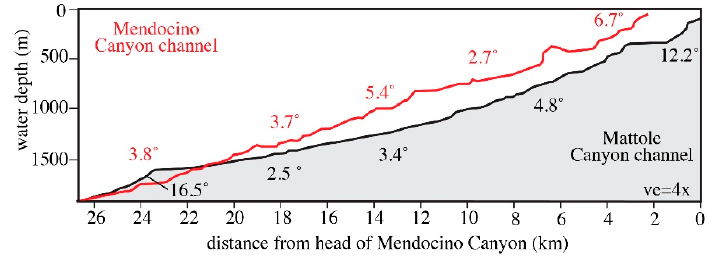
Figure 7. Thalweg profiles of Mendocino Canyon channel (red) and Mattole Canyon channel (black). Note the rough and subtle concave-down profile of Mendocino Canyon channel relative to the smooth but stepped distinct concave-up profile of Mattole Canyon channel.